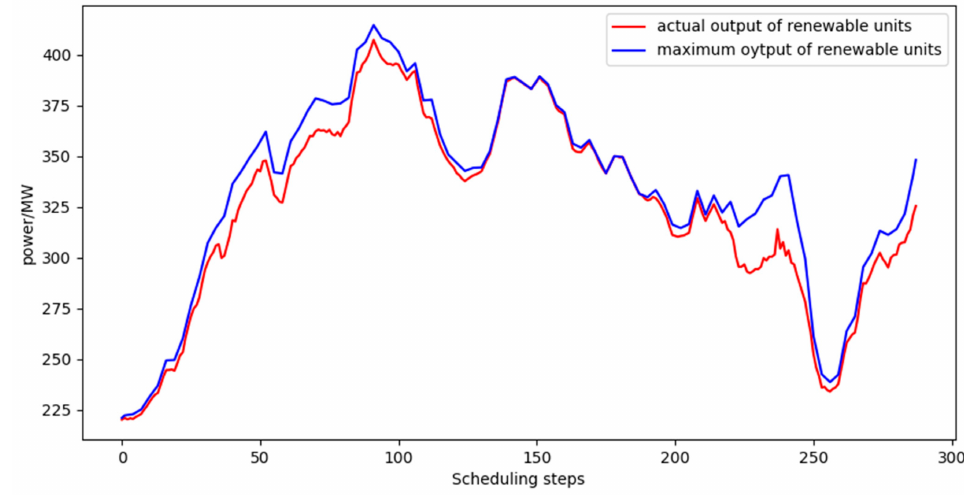
Figure 6. The scheduling period with a fluctuation proportion of the maximum renewable energy output.